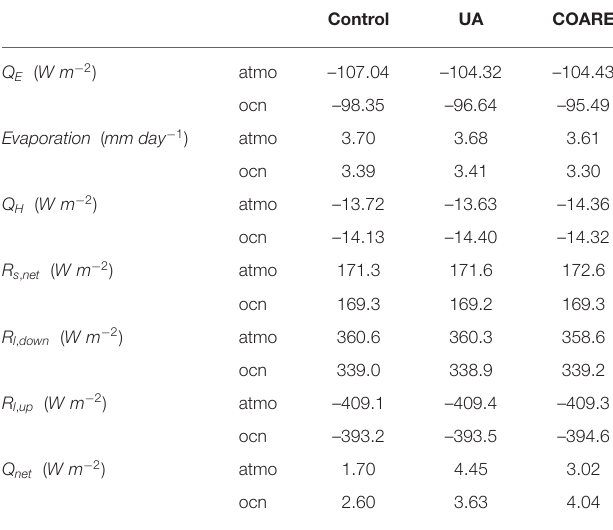
TABLE 2 | Long-term annual mean surface flux components from atmosphere and ocean simulations, averaged over global oceans.